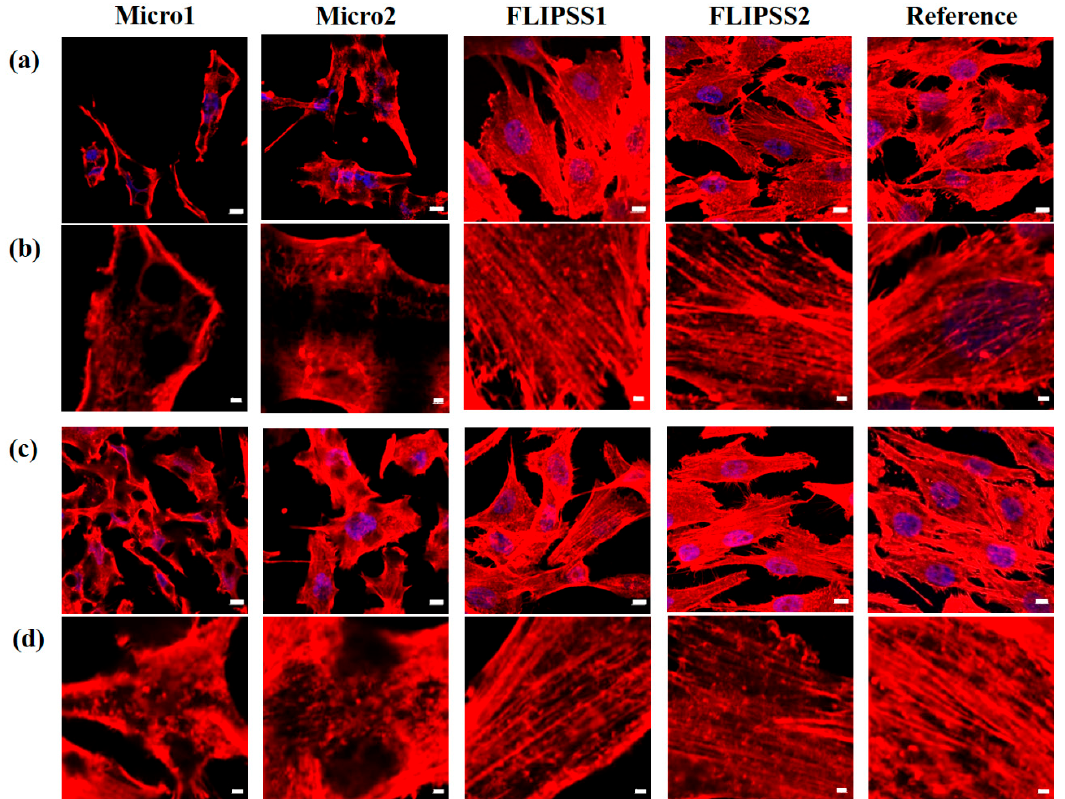
Figure 3. Organization of the actin cytoskeleton in MG-63 cells cultivated for 24 h on nano/micro textured samples. ( a , b ) 1 day after laser structuring, and ( c , d ) 7 days after laser structuring (LSM780, ( a , c ) zoom1, scale bars: 10 µm, ( b , d ) zoom4, scale bars: 2 µm; red: actin, blue: nucleus). Note that the